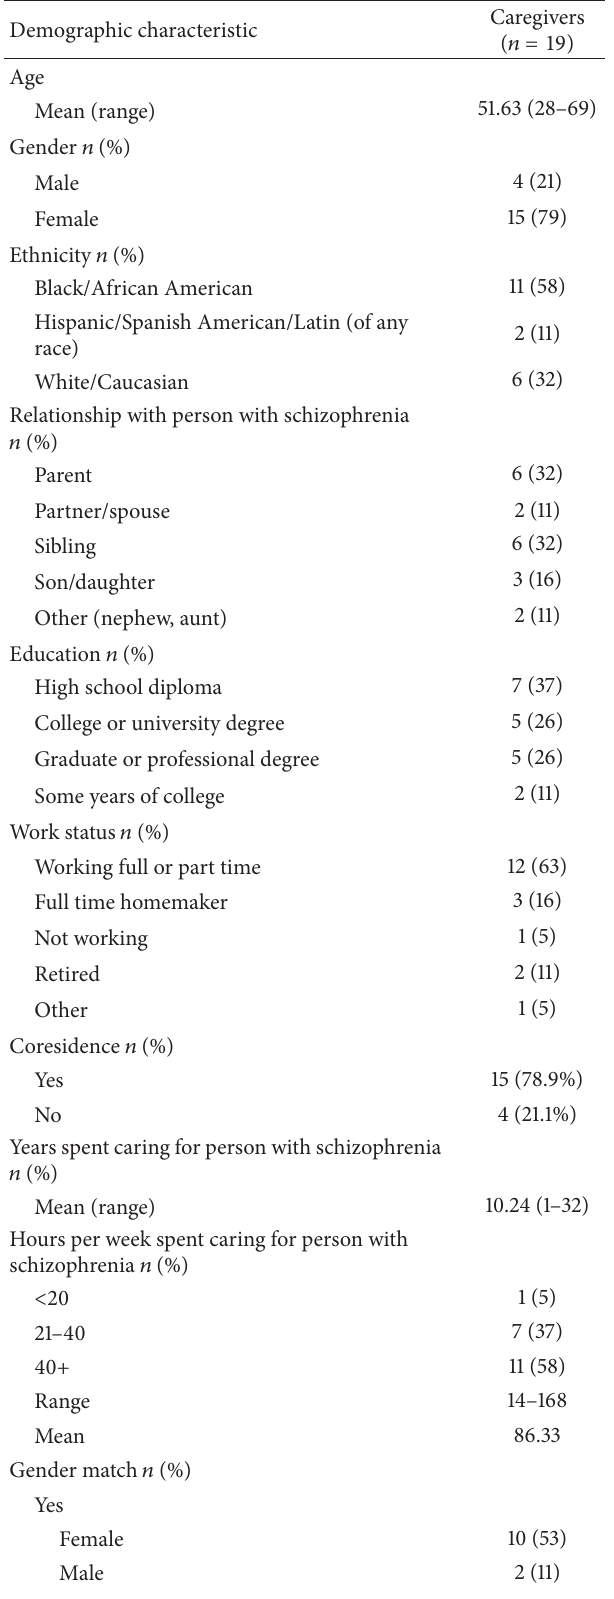
Table 2: Caregiver demographic characteristics ( 𝑛 = 19 ). Demographic